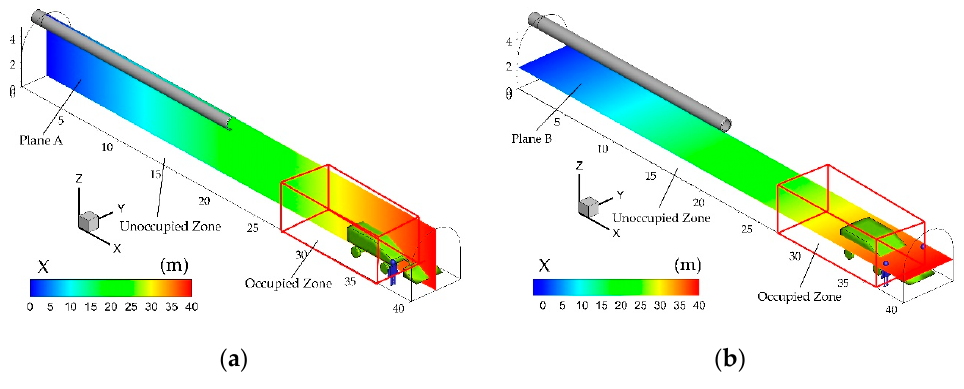
Figure 13. Selection of planes. ( a ) Plane A; and ( b ) Plane B.